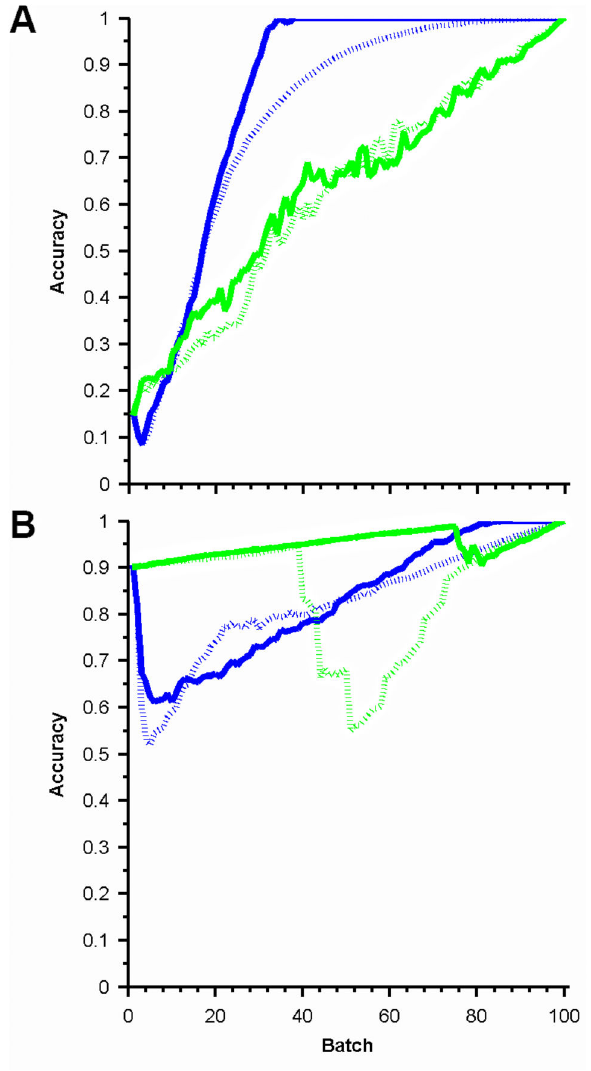
Figure 4. Example learning curves. Mean learning rates for active (solid) and random (dashed) learners across structure learning methods, Full Greedy Merge (blue) and B-Clustering (green). Data from experiments in Figure 3 for (A) (λ (B) (λ =10%, λ r u